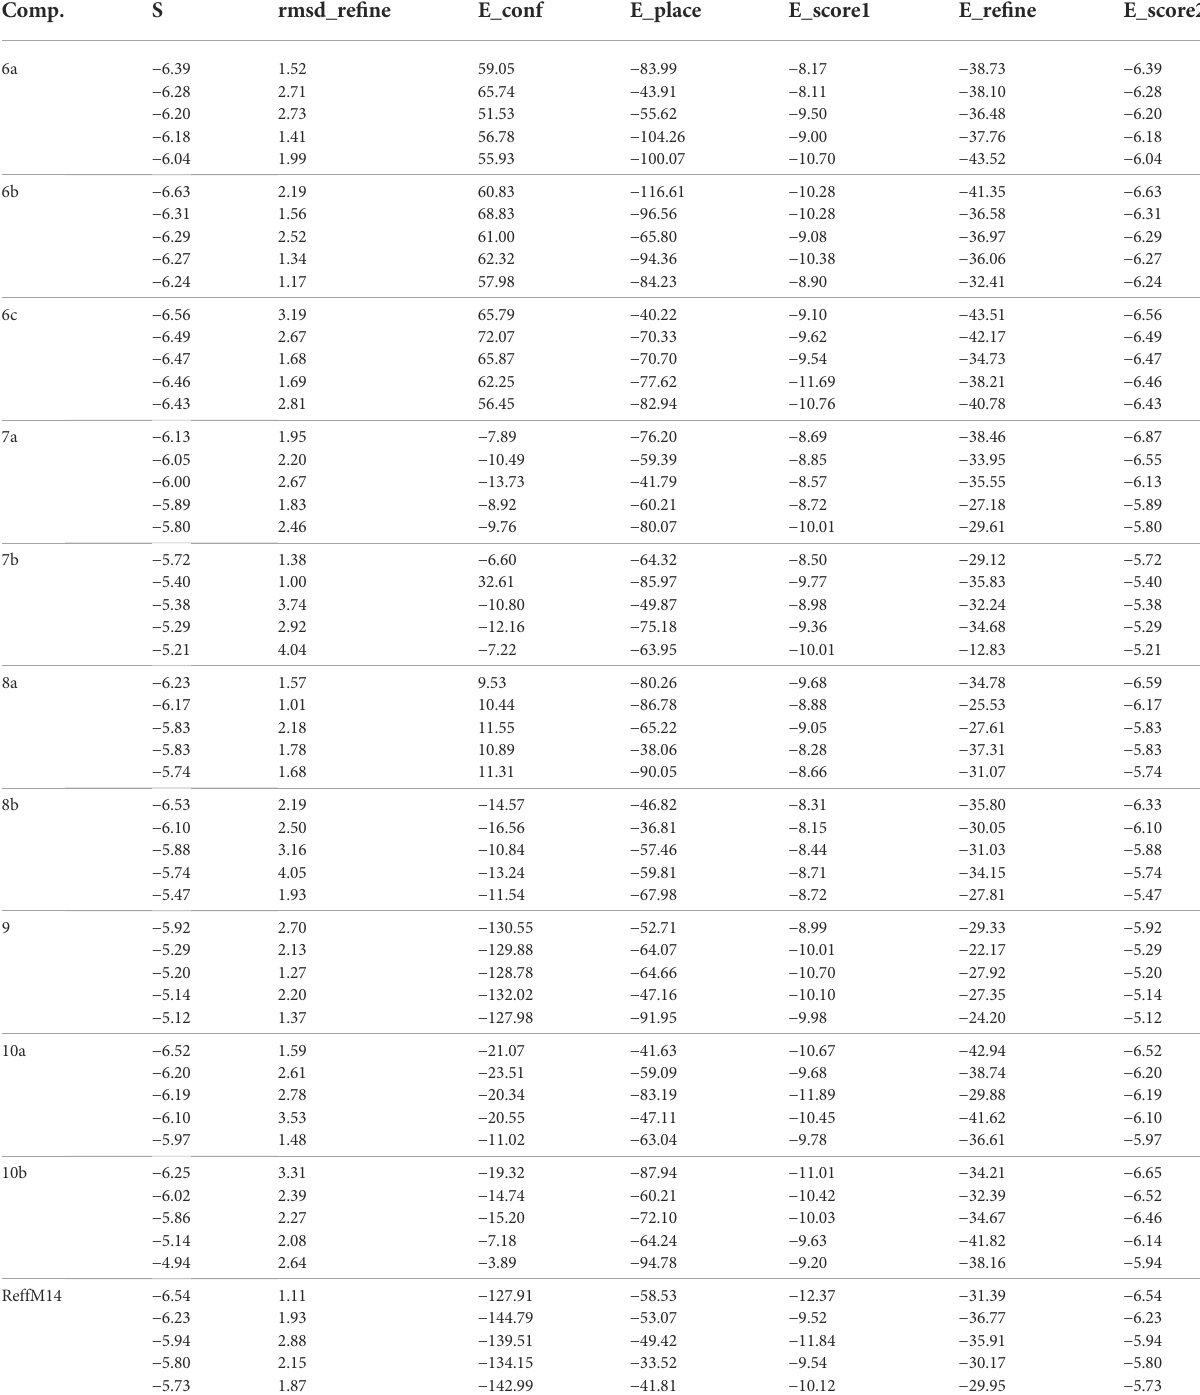
TABLE 2 Docking score and energies of All compounds with 2OPZ “ melanoma cancer protein. ”